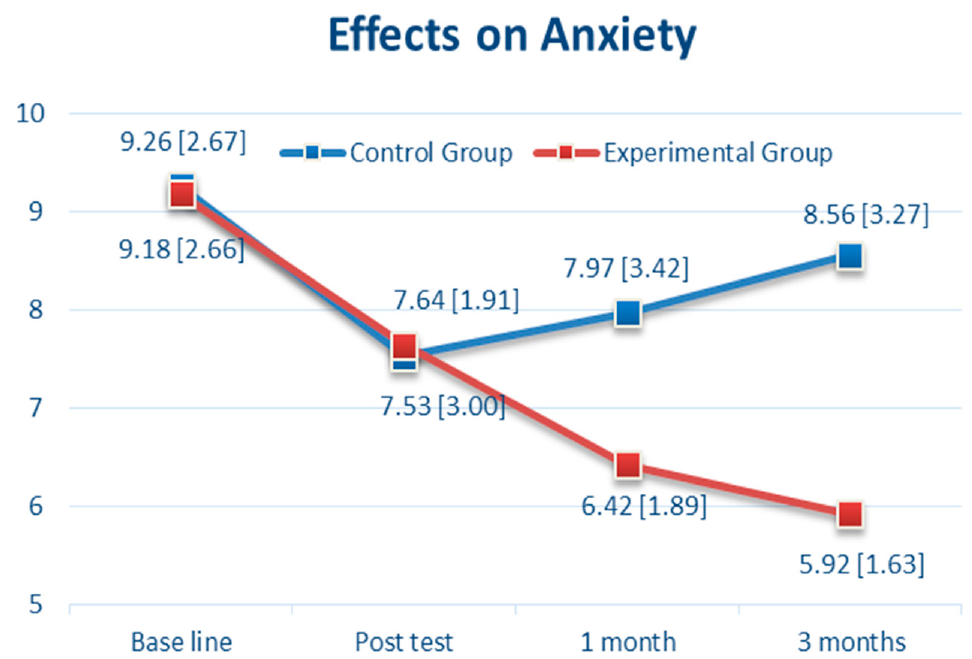
Figure 3. The Effects over Time of Cognitive Behavioral Therapy (CBT) on Anxiety. Regarding the depressive symptoms of the BC patients (as shown in Figure 4), there was no significant difference between the CBTM and control groups at baseline (15.31 vs. 15.03, p = 0.47, 95% CI: − 0.48 to 1.03) and T1 (12.50 vs. 13.15, p = 0.09, 95% CI: − 1.39 to 0.10). However, there was a significant difference between the groups in the depression score at T2 ( p < 0.0001, 95% CI: − 2.53 to − 1.08) and T3 ( p < 0.0001, 95% CI: − 5.92 to − 3.99) (Table 2). The depression score showed a significant reduction to 9.72 (SD 1.70) in the CBTM group compared with the usual care group’s 14.68 (SD 2.32) in T3 (Table 2). As shown in Figure 4, there was a steady reduction in depression from 15.31 (at baseline) to 9.72 (T3) in the CBTM group (5.59 points decreased). Regarding health-related QOL, mental QOL (MQOL) and physical QOL (PQOL) were assessed. For MQOL, there was no significant difference between the CBTM and control groups at baseline (56.39 vs. 56.06, p = 0.89, 95% CI: − 4.56 to 5.22) and T1 (57.50 vs. 55.18, p = 0.29, 95% CI: − 2.03 to 6.68). However, there was a significant difference between groups in the MQOL score at T2 ( p < 0.0001, 95% CI: 2.06 to 9.88) and T3 ( p < 0.0001, 95% CI: 5.52 to 14.0) (Table 2). As shown in Figure 5, there was a steady increase in MQOL from 56.39 (at baseline) to 63.22 (T3) in the CBTM group (6.83 points increased), and a reduction from 56.06 (at baseline) to 53.41 (T3) in the control group (3.09 point decreased). For PQOL, there was no significant difference between the two groups from baseline, T1, T2, and T3 (Table 2). As shown in Figure 6, there was a steady increase in PQOL from 55.75 (at baseline) to 59.28 (T3) in the